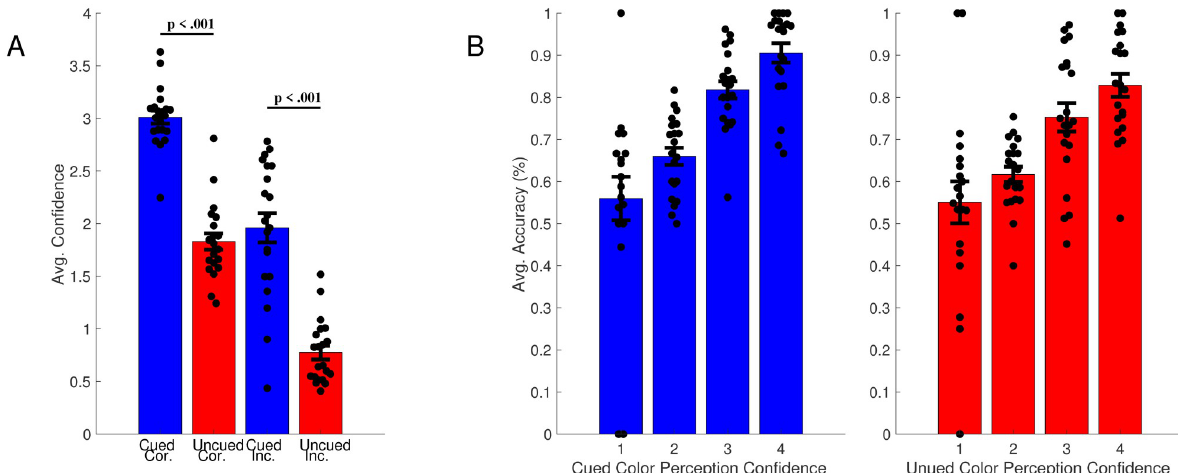
Fig 5. Confidence for correct and incorrect color diversity judgments in Experiment 2. (A) Average confidence for cued and uncued color diversity judgments, separated by whether the judgment is correct or incorrect. As can be seen in the figure, in general, confidence was higher for correct than incorrect judgments, and this was true for both cued and uncued regions of the circle. (B). Average accuracy across color diversity judgments with different confidence levels, for cued and uncued regions. In general, accuracy increased as confidence increased for color diversity judgments in both cued and uncued regions. Error bars show SEM across